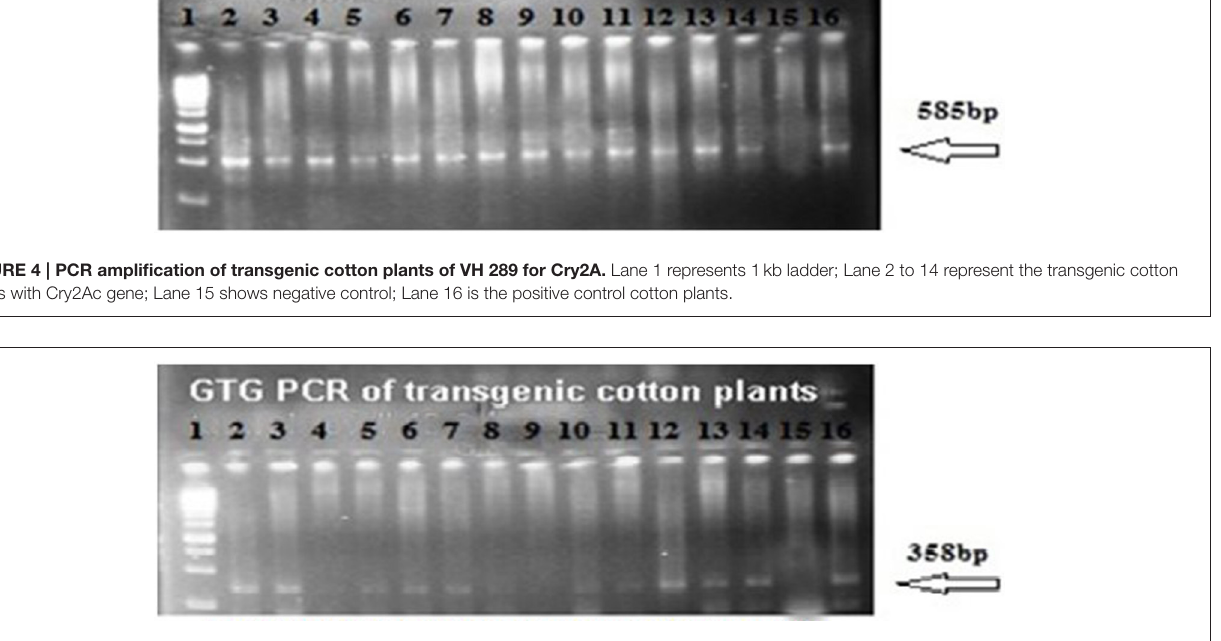
FIGURE 5 | PCR amplification of transgenic cotton plants of VH 289 for GTG-gene. Lane 1 represents 1kb ladder; Lane 2–14 represent transgenic cotton plants with GTG gene; Lane 15 represents negative control; Lane 16 represents positive control.